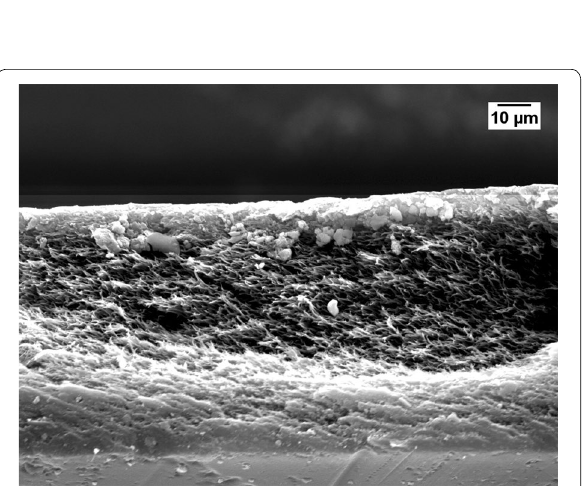
Fig. 6 Cross‑section image of NMP membrane made by 27 wt%